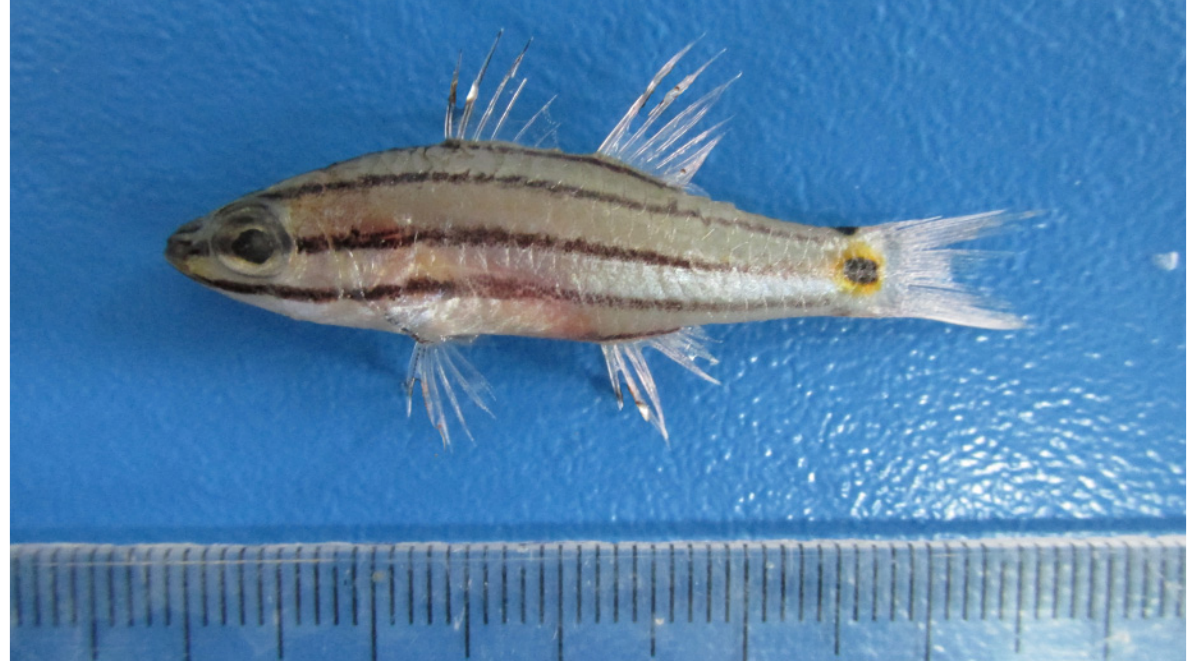
Fig. 1. Indian Ocean twospot cardinalfi sh, Cheilodipterus novemstriatus , from the Cevlik harbour (Iskenderun Bay)